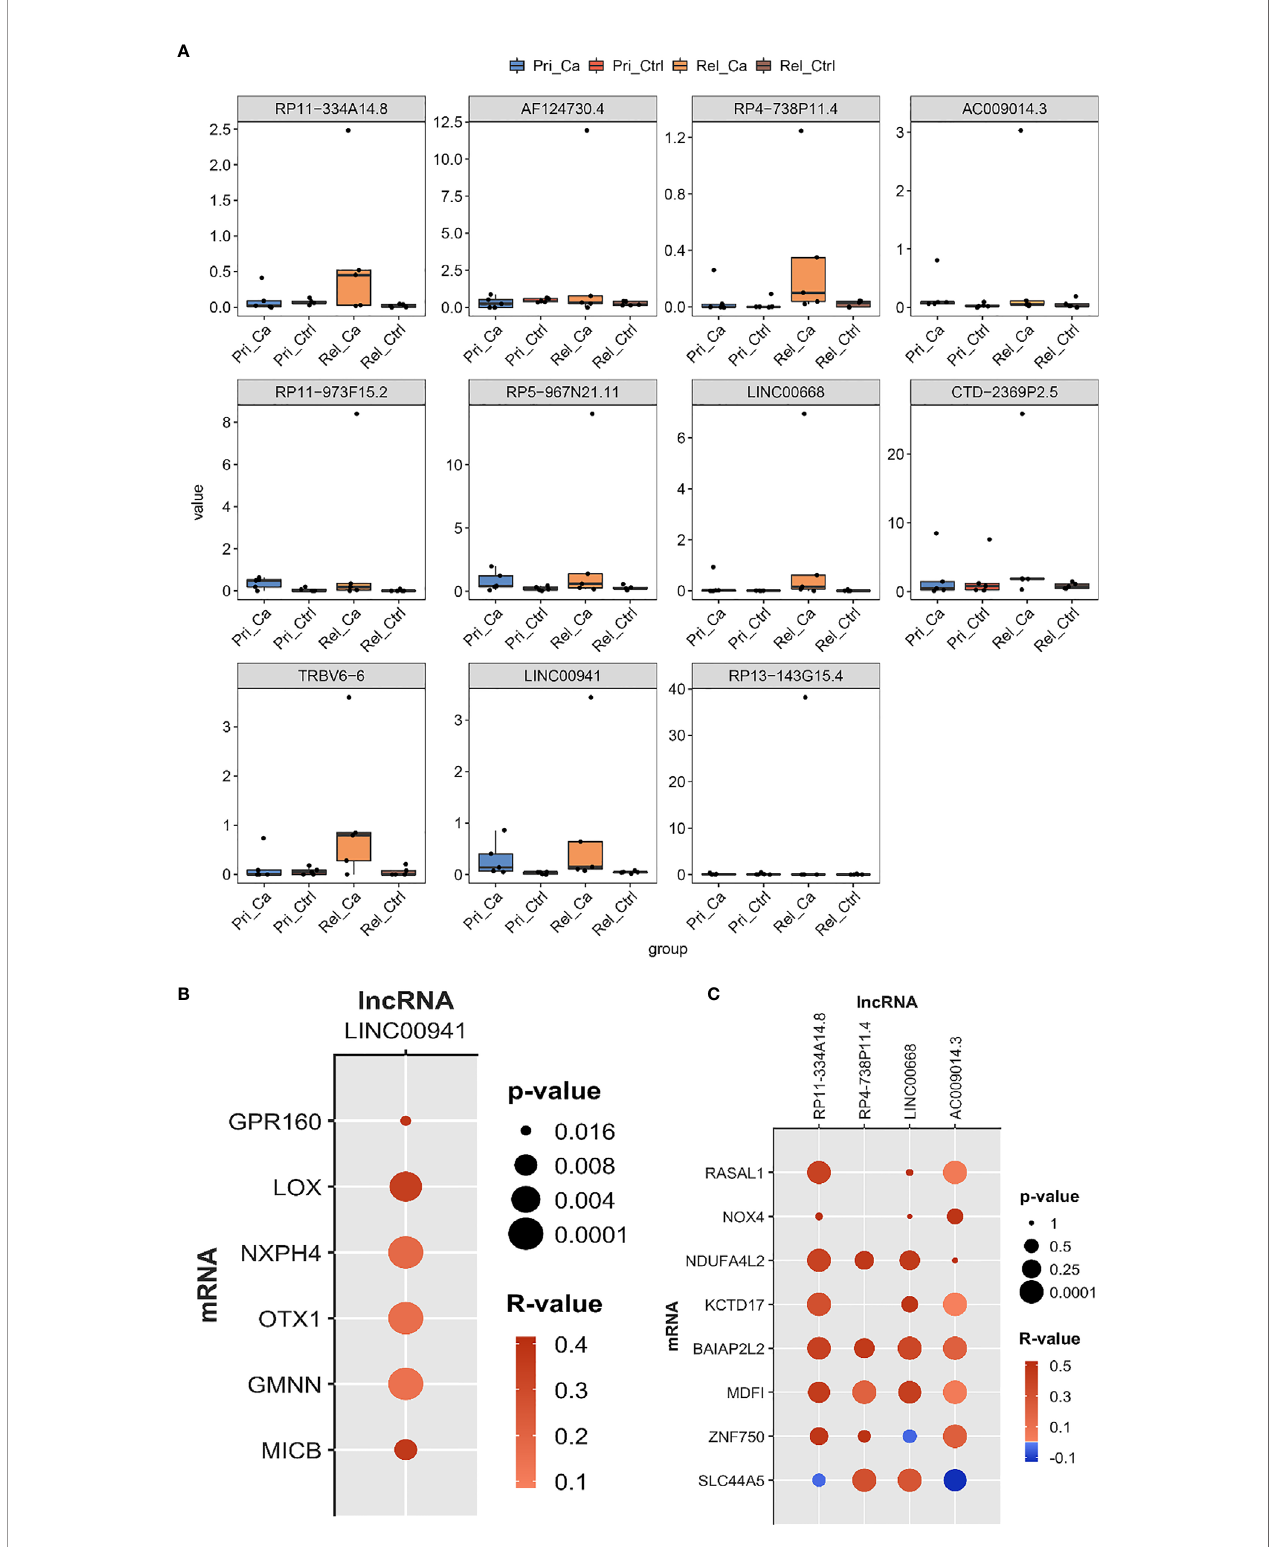
FIGURE 6 | Identify hub lncRNAs based on expression level and correlation analysis. (A) The results of co-expression network and WGCNA selected the expression level of lncRNA in GSE101432. (B, C) The bubble chart was used to show the correlation analysis between lncRNAs and co-expressed